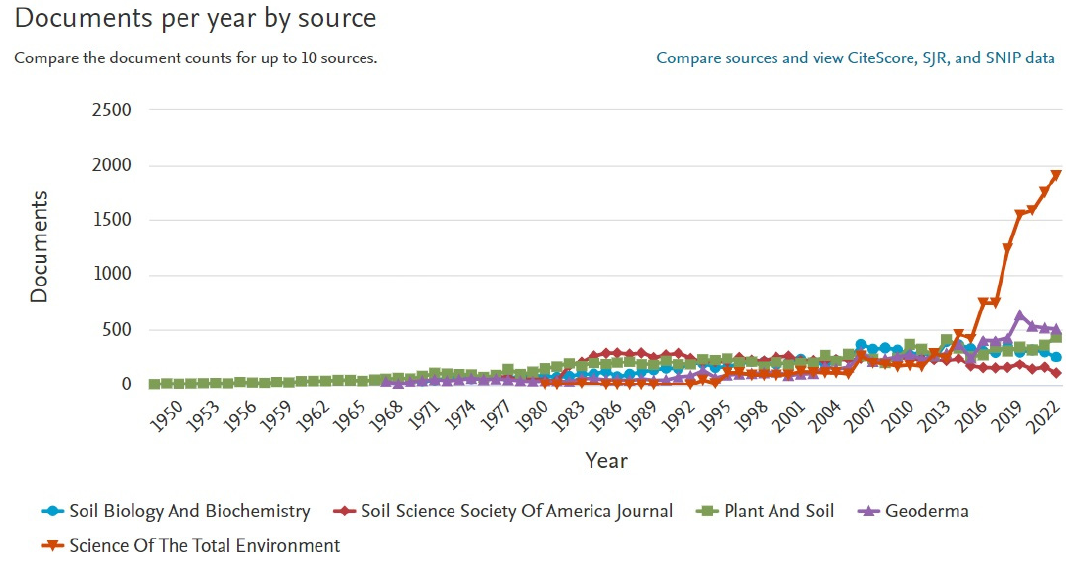
Figure 1. Search results for Soil with Scopus.